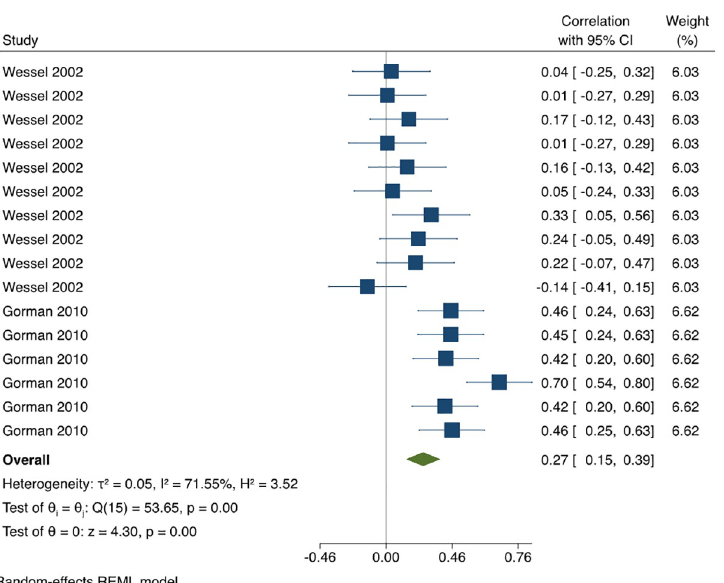
Fig 4. Meta-analysis of Pearson correlation between OSCEs stations in physical therapy students. Forest plot presenting the meta-analyzed estimate on Pearson’s r. Each square presents the results of an individual study with the size of the square being proportional to the weights used in the meta-analysis and the horizontal lines indicating the 95% confidence intervals. The solid vertical line represents no reliability, and the solid diamond indicates the overall summary measure.